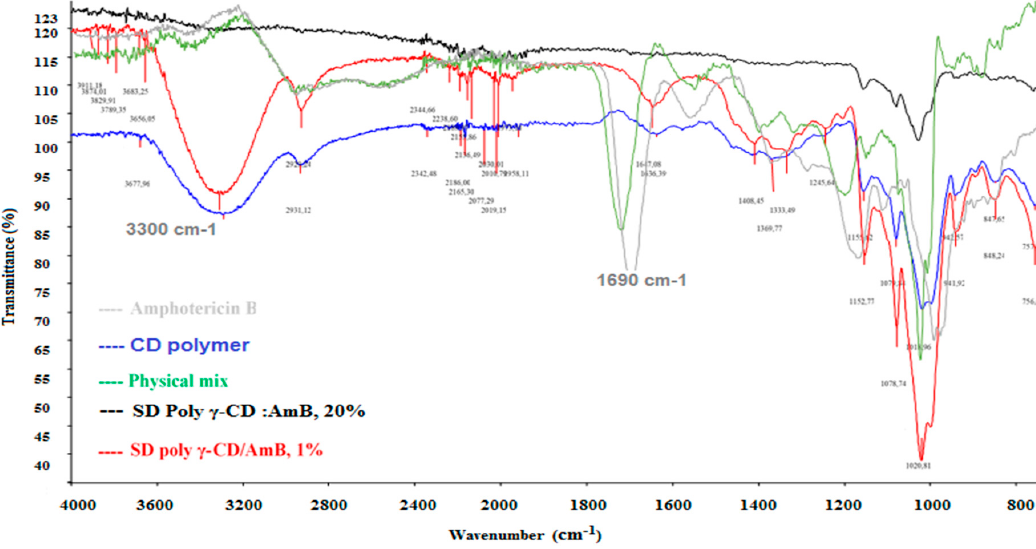
Figure 5. FTIR spectra of amphotericin B, uncharged solid dispersion of γ -cyclodextrin polymer (poly γ -CD), physical mixture and amorphous solid dispersion based γ -cyclodextrin polymer and AmB (SD poly γ -CD/AmB).